Question: Judging by this figure, is the value going up or going down?
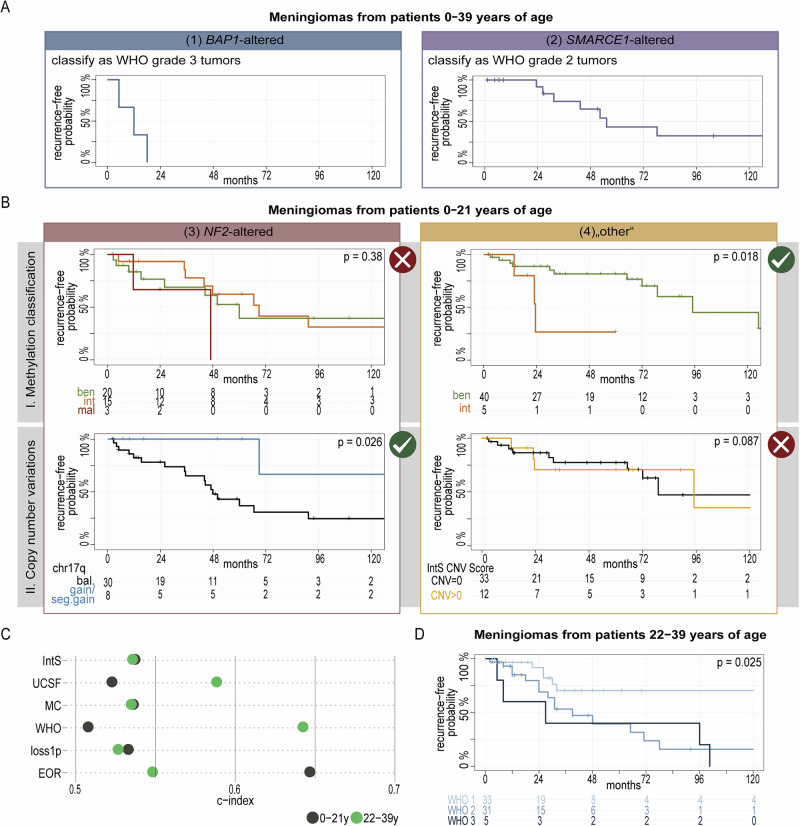
Answer: decreasing